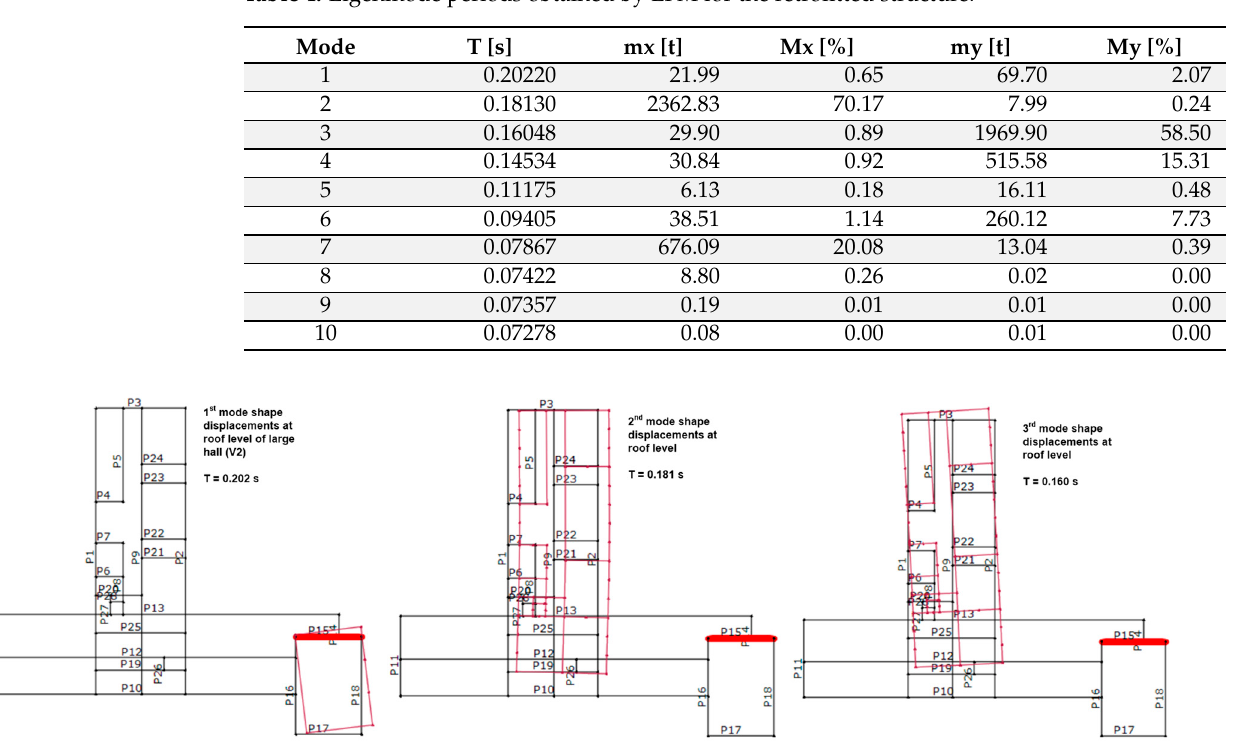
Figure 28. Relevant mode shapes obtained by EFM for the retro fi tt ed structure.